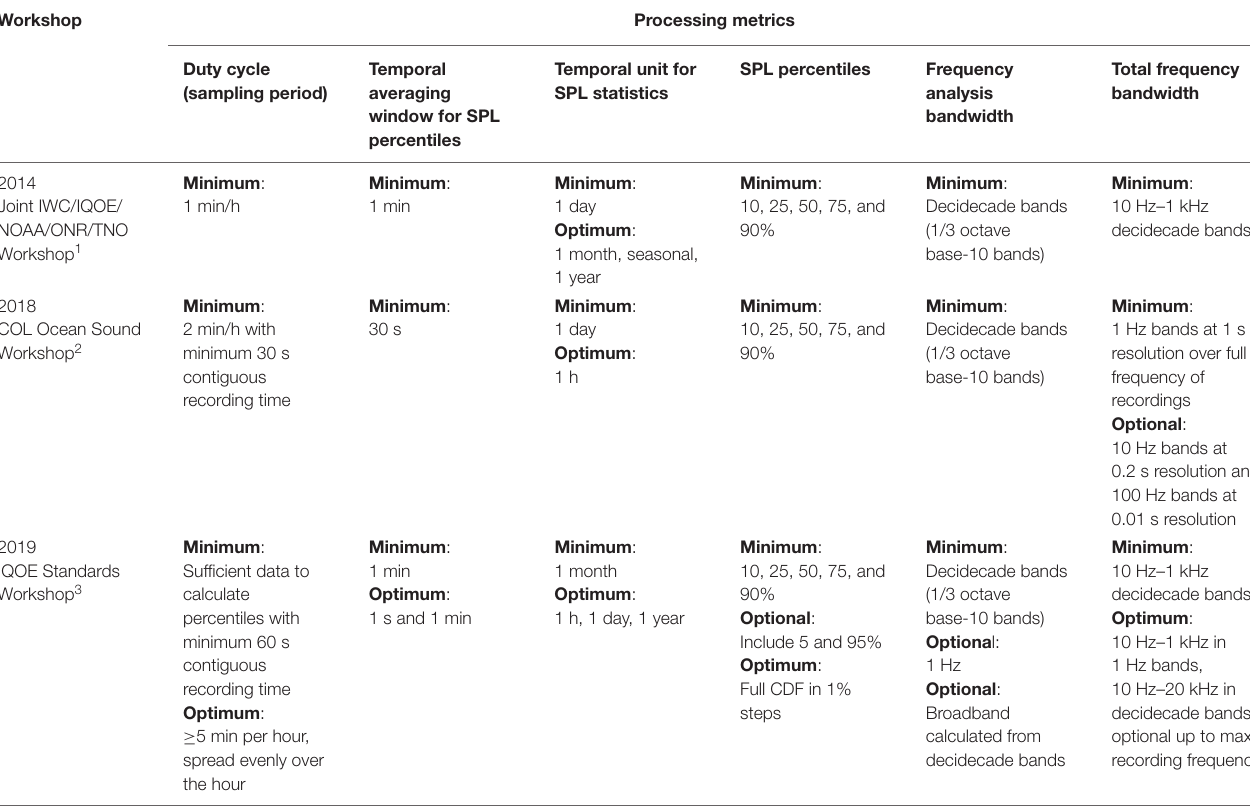
TABLE 1 | Recommendations from international workshops focused on soundscapes and trends in ocean sound.